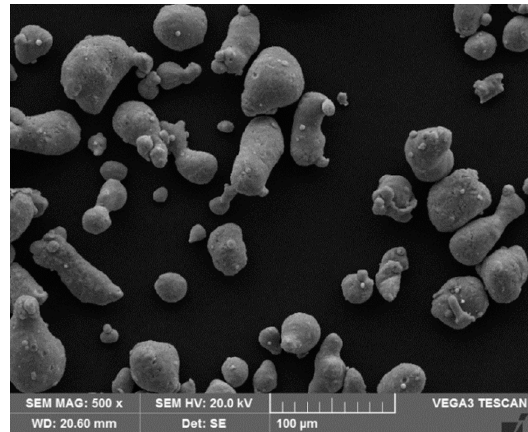
Figure 1. The morphology of AlSi10Mg powder particles.